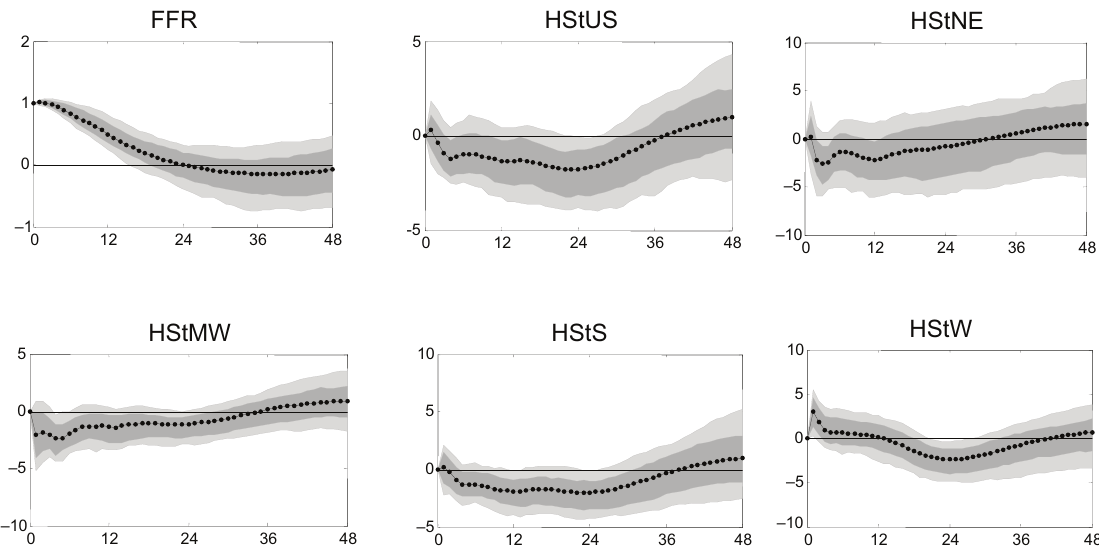
Figure 5. effect of 100-basis-point monetary policy shock on housing starts